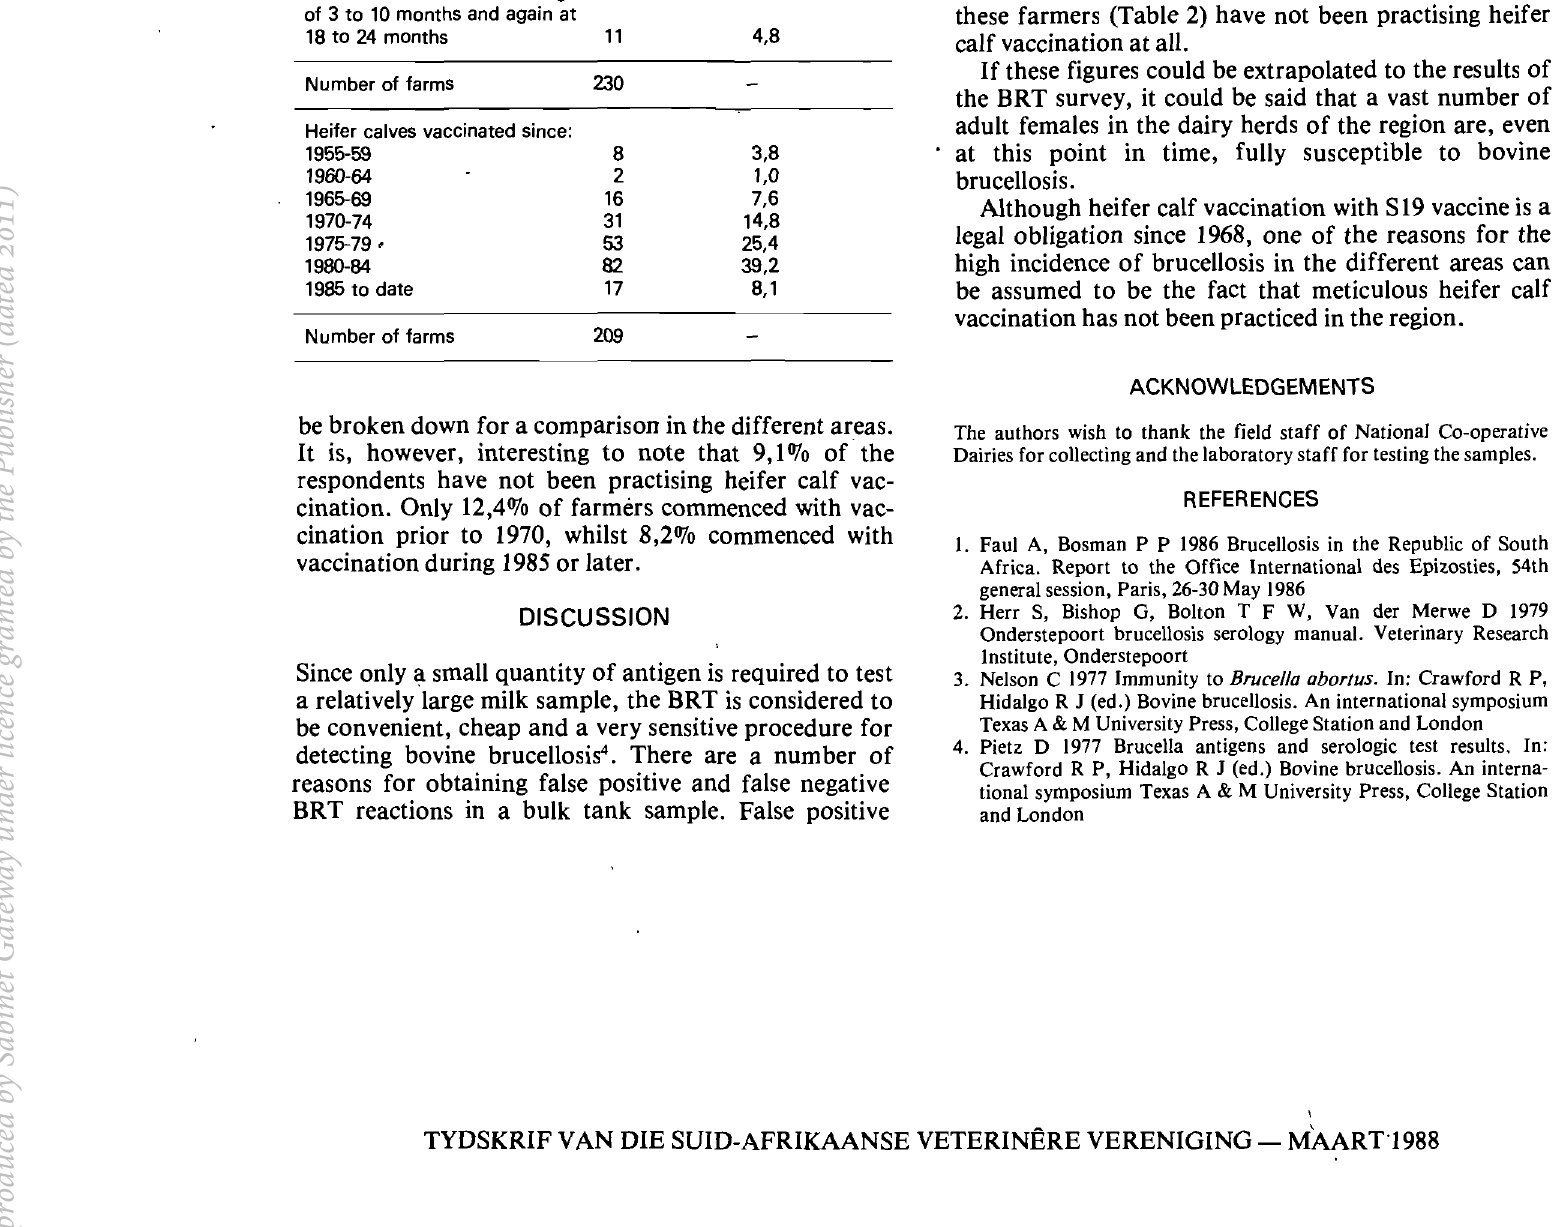
Table 2: Heifer calf vacCination with strain 19 vaccine. Action on farms Number of herds% Heifer calves not vaccinated at all 21 9,1 Heifer calves vaccinated once at age of 3 to 10 months 198 86,1 Heifer calves vaccinated at age of 3 to 10 months and again at 18 to 24 months 11 4,8 Number of farms 230 Heifer calves vaccinated since: 1955-59 2011